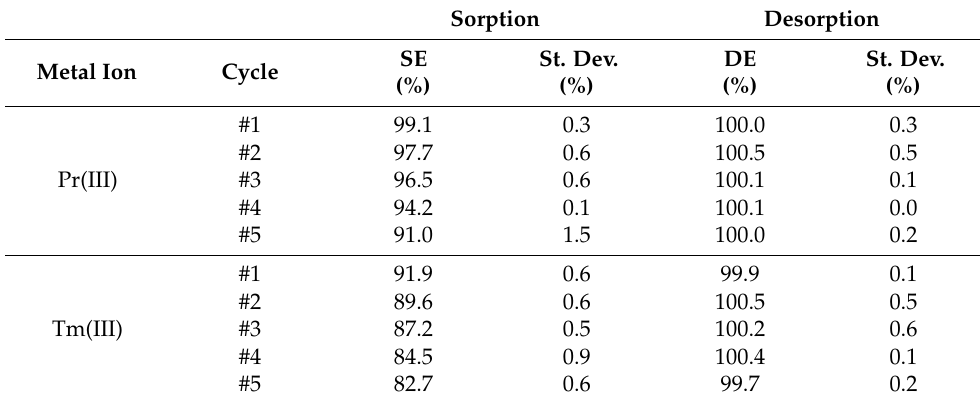
Table 8. Sorption and desorption performances (efficiencies, %) for five successive cycles for Pr(III) and Tm(III) recovery using the P2-APEI sorbent. Sorption